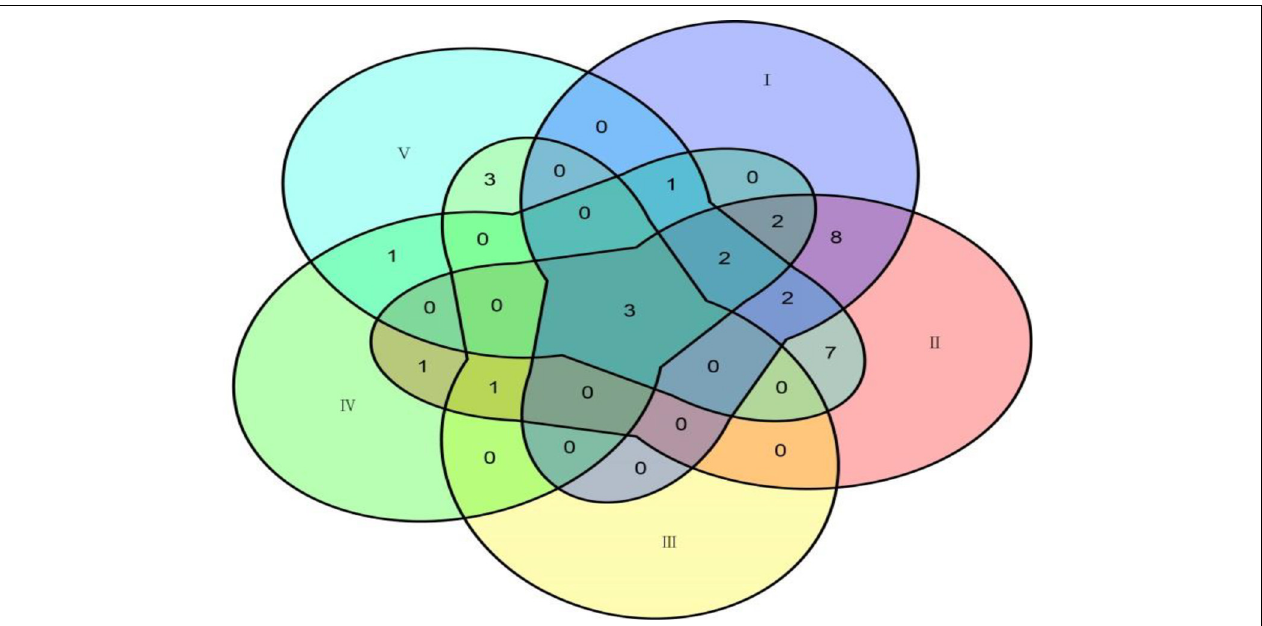
FIGURE 3 | The connection of common QTNs detected by five methods. Method numbers correspond to (I) mrMLM, (II) FASTmrMLM, (III) FASTmrEMMA, (IV) pLARmEB, and (V) ISIS EM-BLASSO.